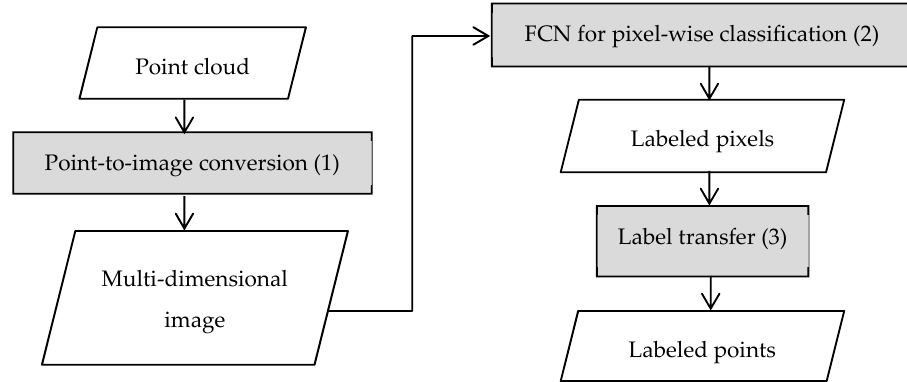
Figure 1. The general workflow of the proposed classification approach.